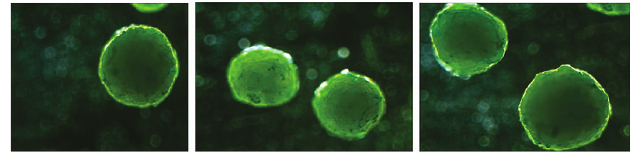
FIGURE 6 - Images of methotrexate coated pellets.